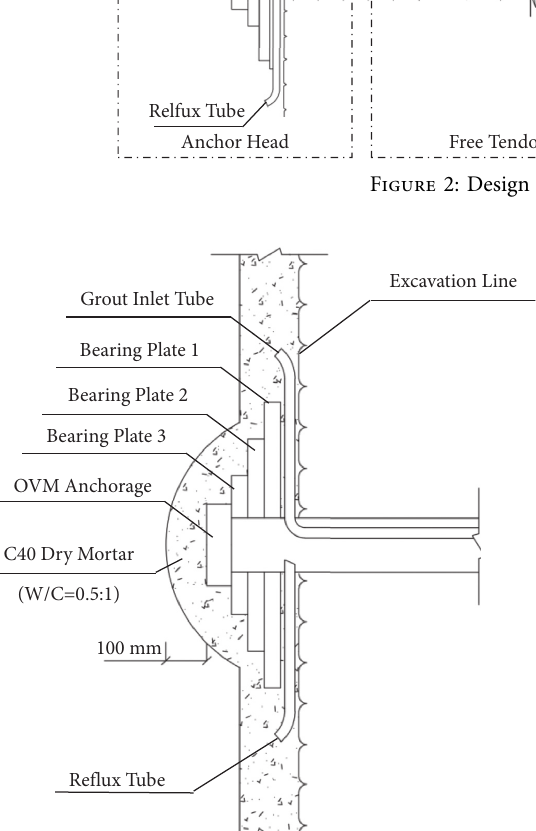
Figure 3: Design drawing of the anchor head.